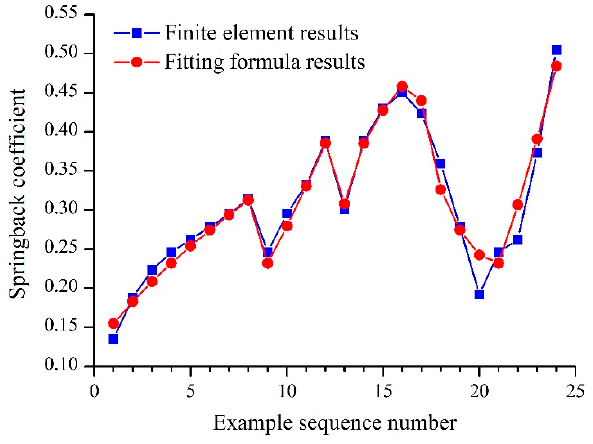
Figure 10. Comparison of fitting formula results with FE results.